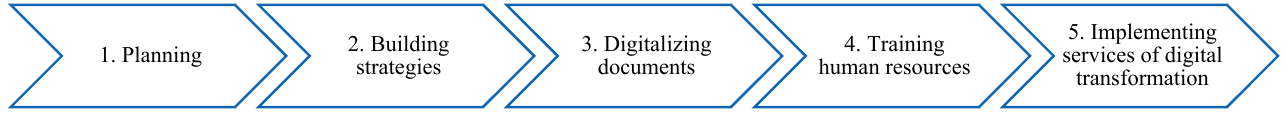
Figure 1. Process of digital transformation in business.